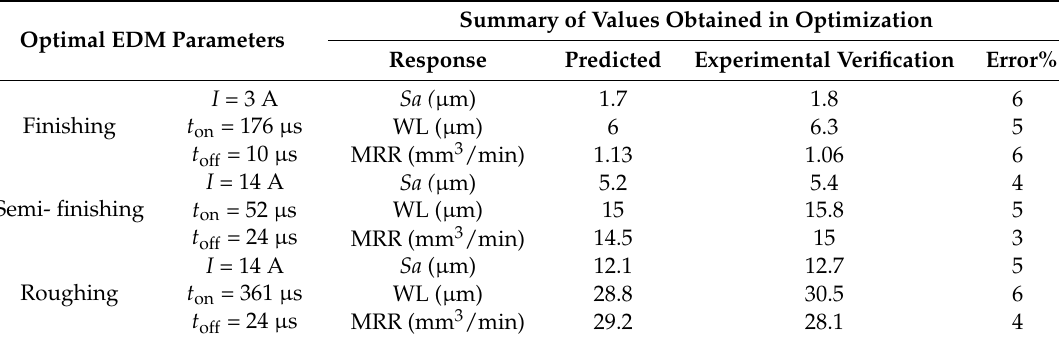
Table 10. The experimental validations of the multi-response optimizations.